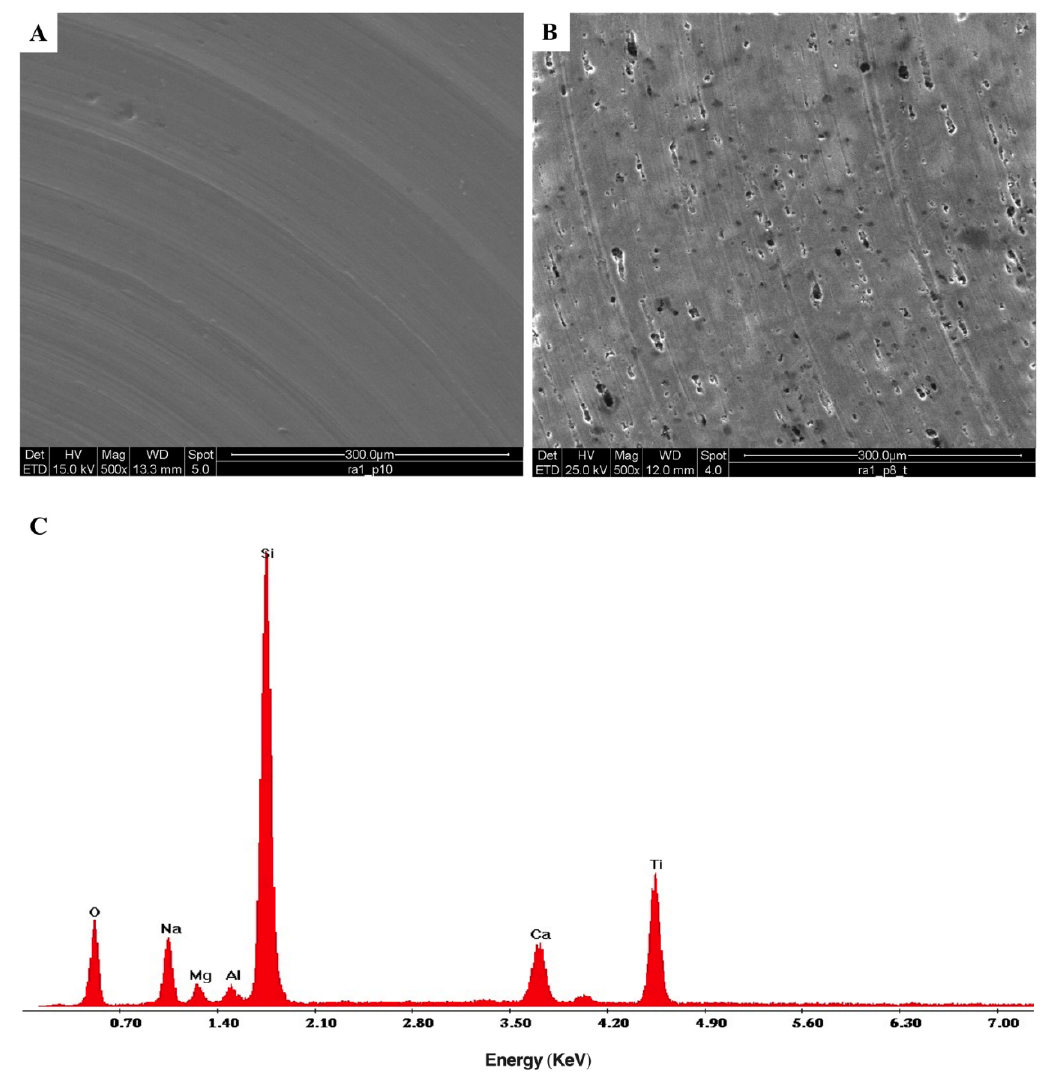
Figure 6. ESEM morphological analysis of ( A ) uncoated, ( B ) DURALTI ® -coated aluminum disks at 1 µ m roughness; ( C ) X-EDS microanalysis of a DURALTI ® -coated aluminum disk at 1 µ m roughness.